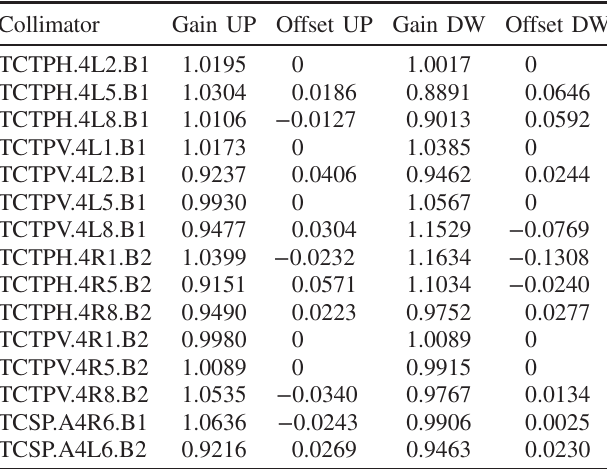
TABLE I. Determined gain and offset coefficients to counter for asymmetries in the electronics in the received electrode signals (UP ¼ upstream, DW ¼ downstream).